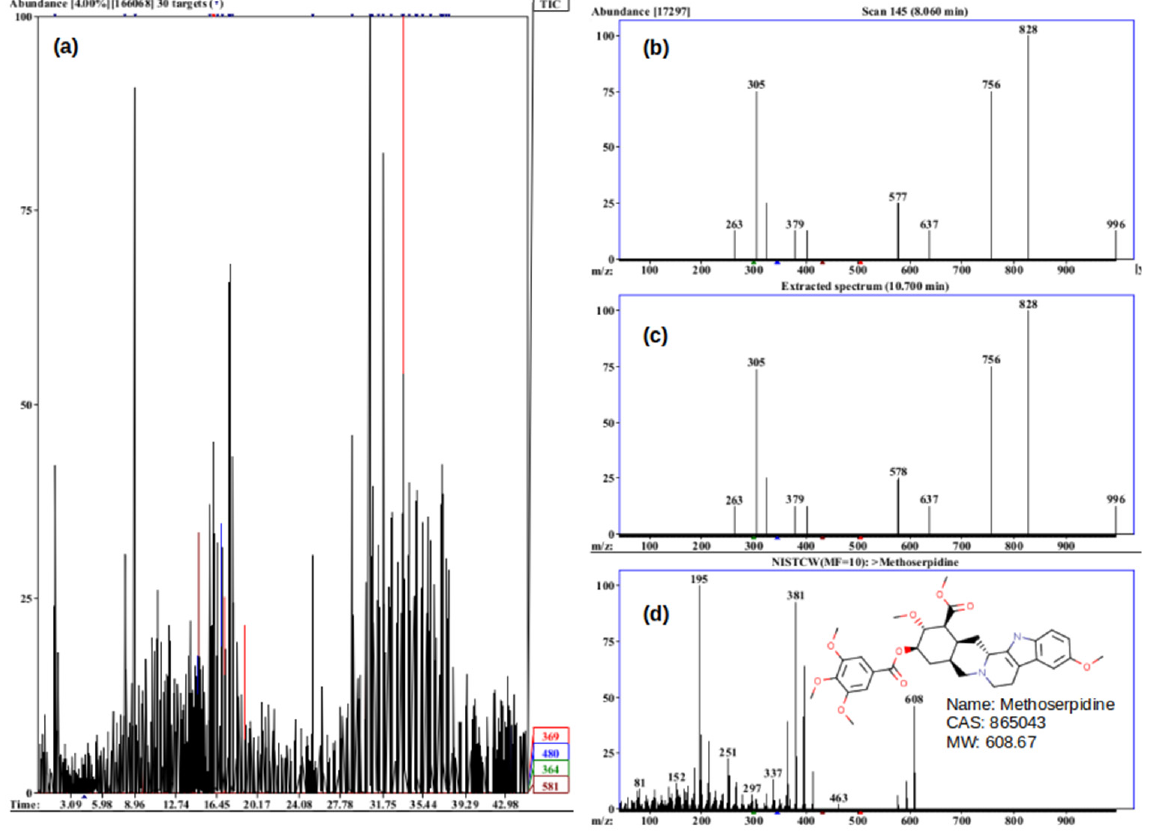
Figure 1. The ( a ) chromatogram, ( b ) scan, ( c ) extracted and ( d ) suggested target methoserpidine (CAS number: 865043) mass spectra derived from one of the three samples.